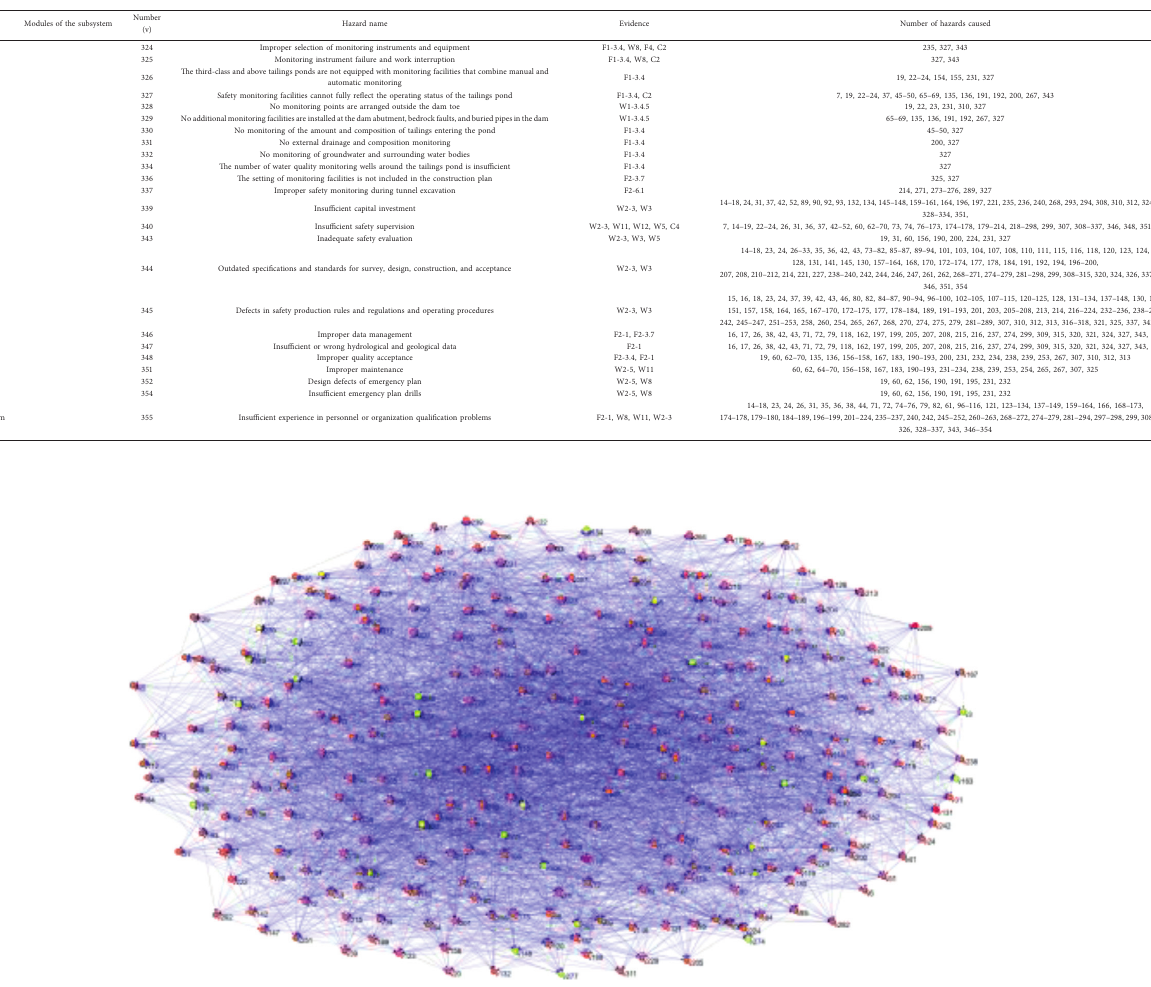
Figure 3: Model of the